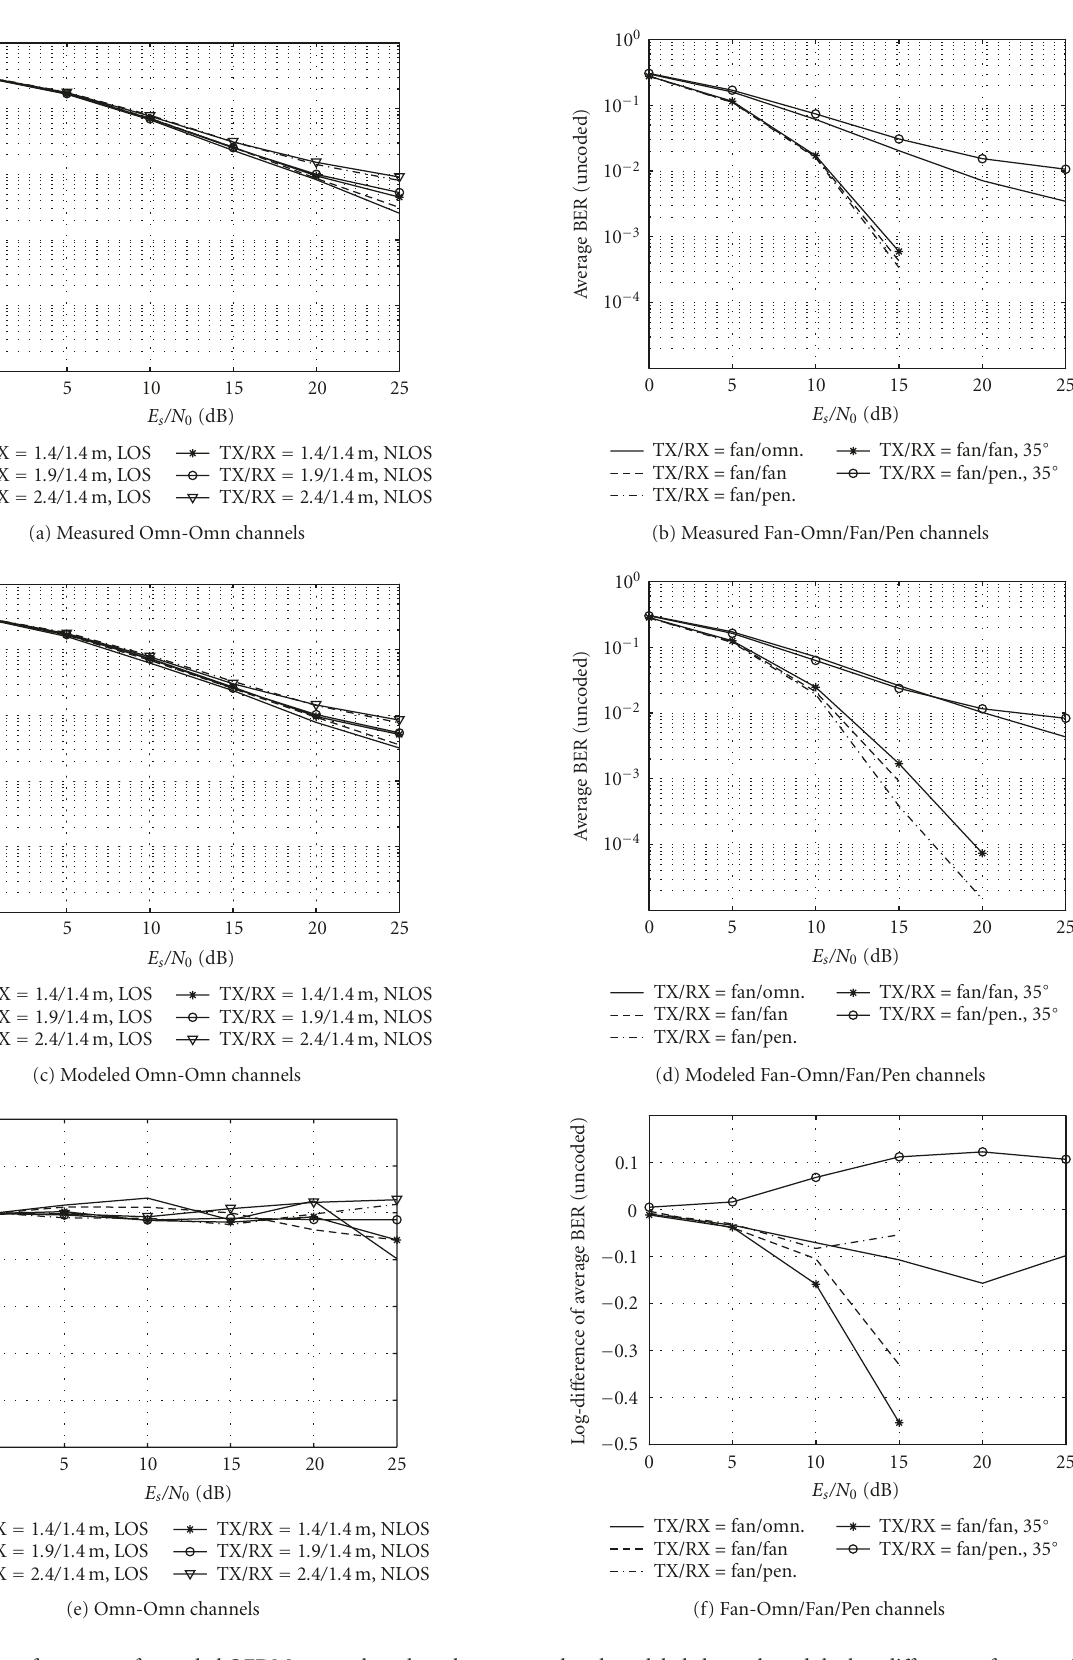
Figure 8: BER performance of uncoded OFDM system based on the measured and modeled channels and the log-di ff erence of average BER between